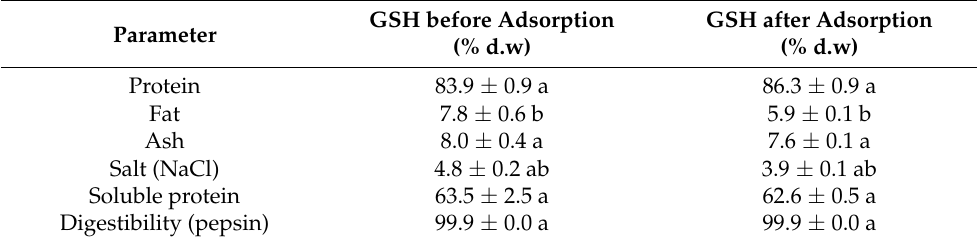
Table 3. Characterization (%) of the GSH sample from batch 2 (20.97 mg L − 1 ) before and after the cadmium adsorption in fixed-bed columns connected in series . The experimental conditions were a pH of 6.2, a flow rate of 140 mL min − 1 , and a temperature of 55 ◦ C. The results are expressed as the dry weight and are the average of three